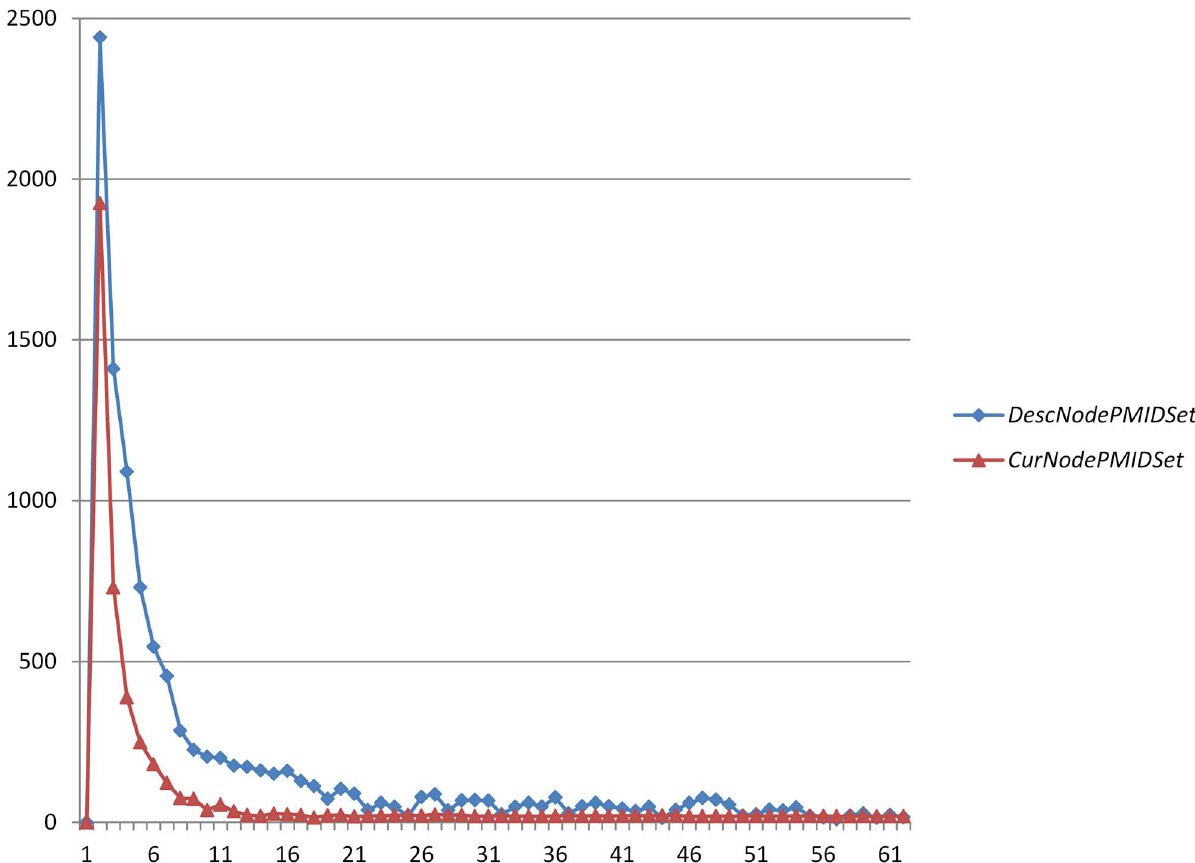
Figure 3. Distribution of the document numbers in DescNodePMIDSet / CurNodePMIDSet of each GO node in the tree structure.